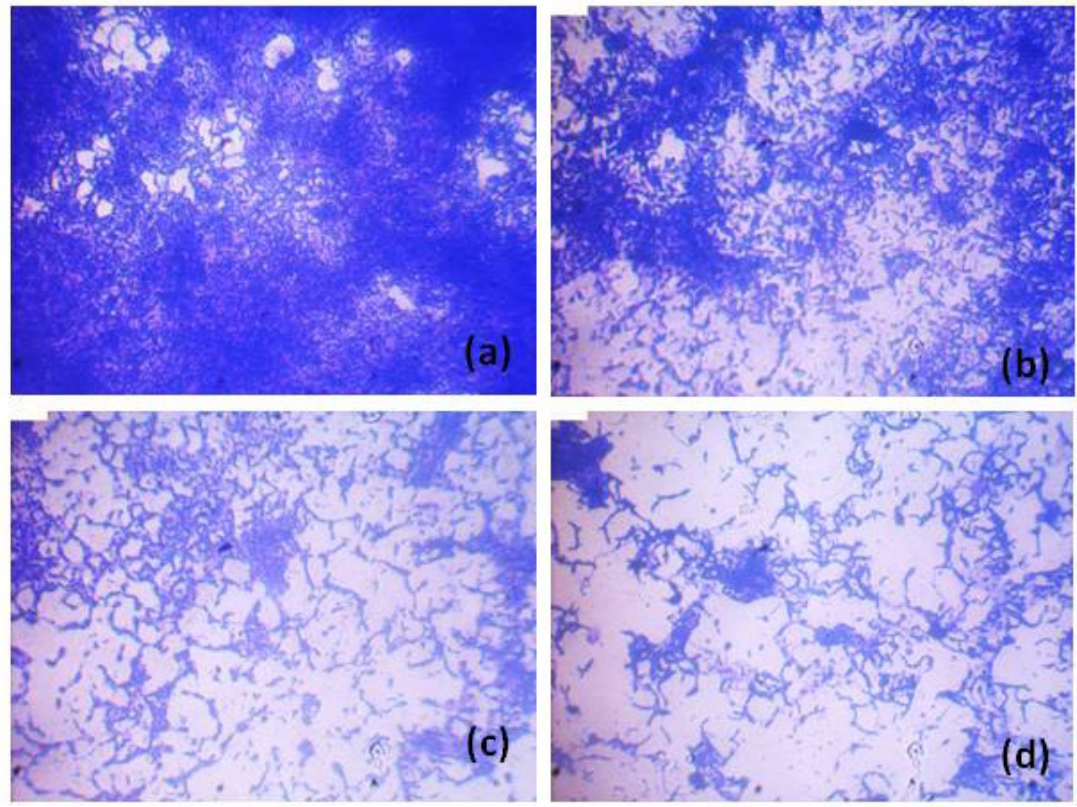
Figure 4. Light microscopy analysis showing the biofilm inhibitory potential of HANPs against P. aeruginosa ATCC 10145 at increasing concentrations. Control, treated with HANPs at 0 μg mL −1 ( a ); biofilm formed in the presence of HANPs at 10 μg mL −1 ( b ), 25 μg mL −1 ( c ), and 50 μg mL −1 ( d ).